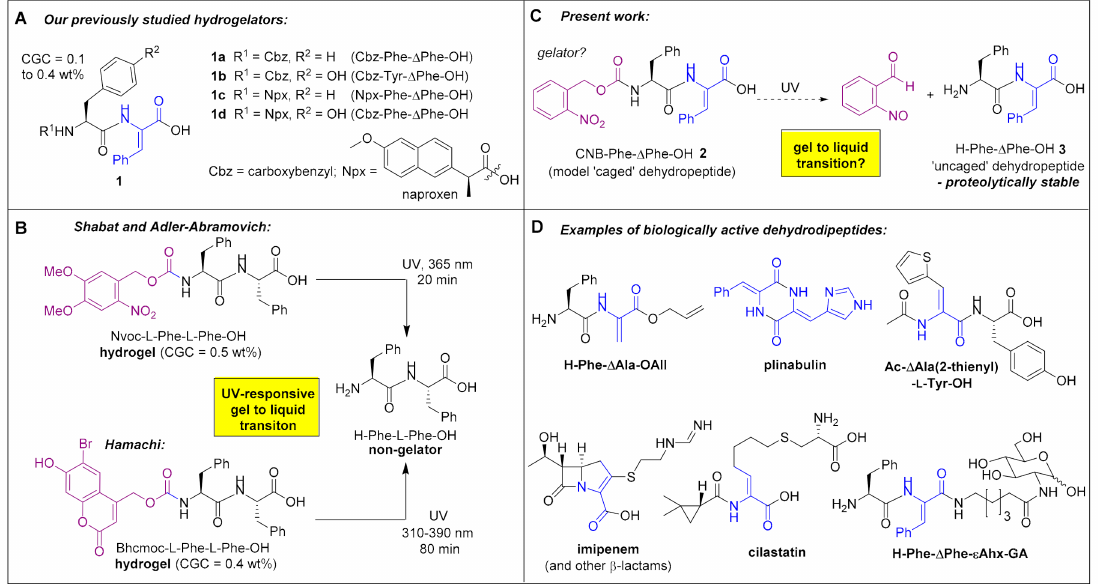
Figure 1. Panel ( A ): Our previously reported aromatic-capped dehydrodipeptide hydrogelators 1a – d . Panel ( B ): Previous UV-responsive peptide hydrogel system based on the photo-cleavage of Ar-Phe-Phe-OH to H-Phe-Phe-OH. Panel ( C ): Our target CNB-capped peptide 2 and how it might act as a photo-responsive hydrogel for the light-triggered release of dehydrodipeptide 3 . Panel ( D ): Structures of known biologically active dehydrodipeptides—the system illustrated in Panel C could potentially be adapted for the release of therapeutic molecules. H-Phe- ∆ Ala-OAll is a cathepsin B inhibitor, plinabulin is in phase 3 clinical trials for non-small cell lung cancer, Ac- ∆ Ala(2-thienyl)-Tyr-OH activates macrophages for the selective killing of cancer cells. Imipenem/cilastatin in combination is a wisely used antibiotic. H-Phe- ∆ Phe- ε Ahx-GA is an antimicrobial compound